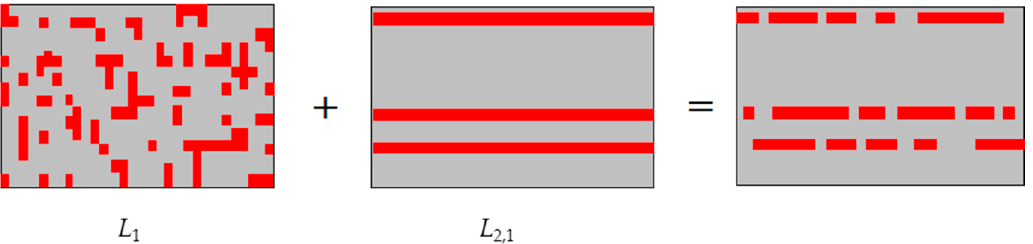
Figure 1. The diagrammatic sketch of different norms.